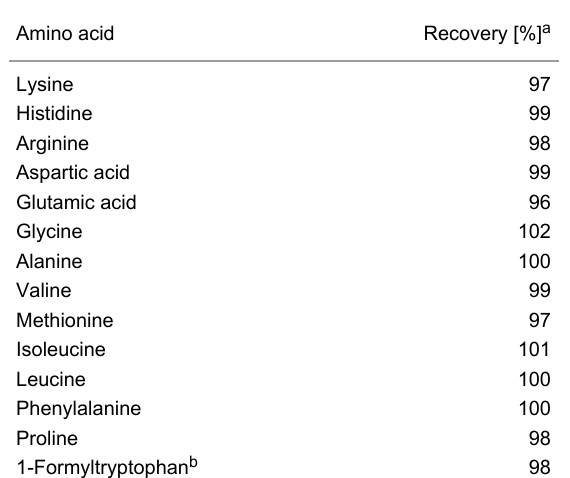
Table 1: Recovery of amino acids after trifluoroacetic acid–acetyl chlo- ride treatment as reported by Previero, Barry and Coletti-Previero in 1972